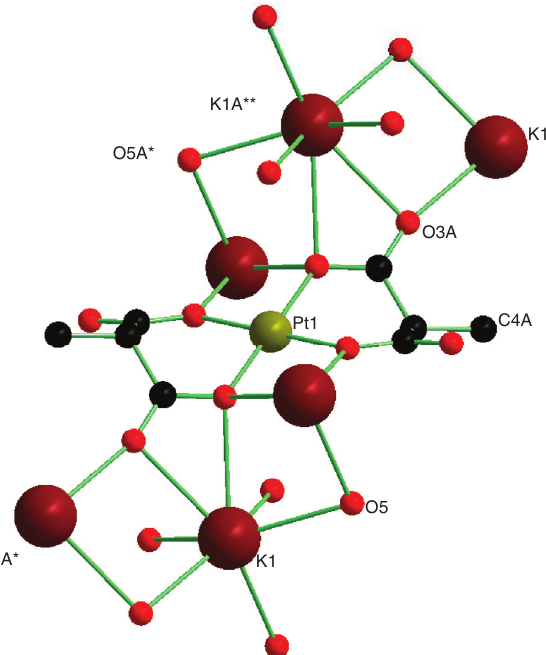
Figure 9 Simplified view of the molecular structure (diamond) of K Pt(memal) ‧2H O (Dunham et al., 2 2 2